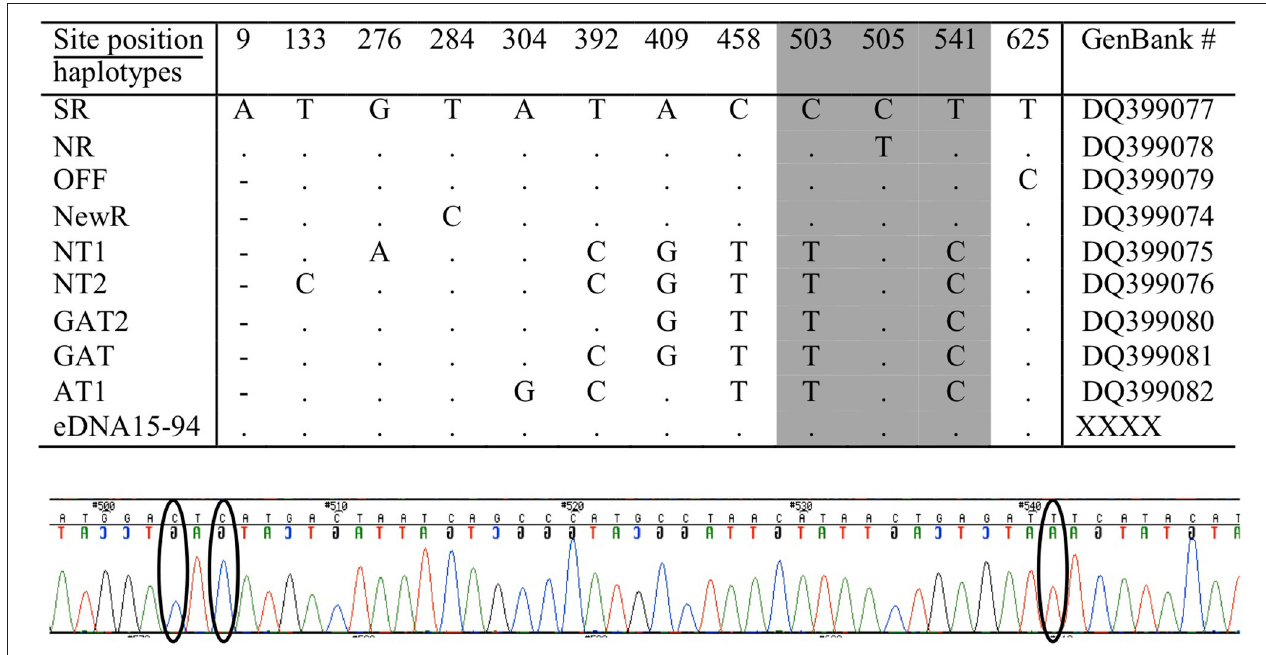
FIGURE 7 | The positions of variable sites in the mtDNA control region of the killer whale, considered to be diagnostic (or characteristic) of ecotypes and communities in the North Pacific (note that numbering differs slightly) from (Parsons et al., 2013). Amplification and sequencing of eDNA from three samples of encounter #e46 matched the southern resident (SR), as shown on the first line, at all 12 variable sites. A representative segment of the sequencing electropherogram from encounter #e46 (sample eDNA15 #s94) is included to show the location of three diagnostic sites (indicated by ellipses), including position 505 that distinguishes the southern resident community (Haplotype SR) from the northern resident community (Haplotype NR). Other abbreviations refer to populations or ecotypes as reported in Parsons et al.